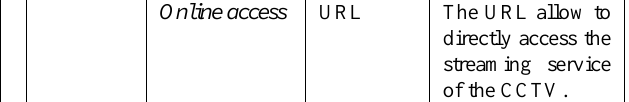
Table 1. Metadata of CCTV monitor designed based on 5W1H FOV Analysis of CCTV System